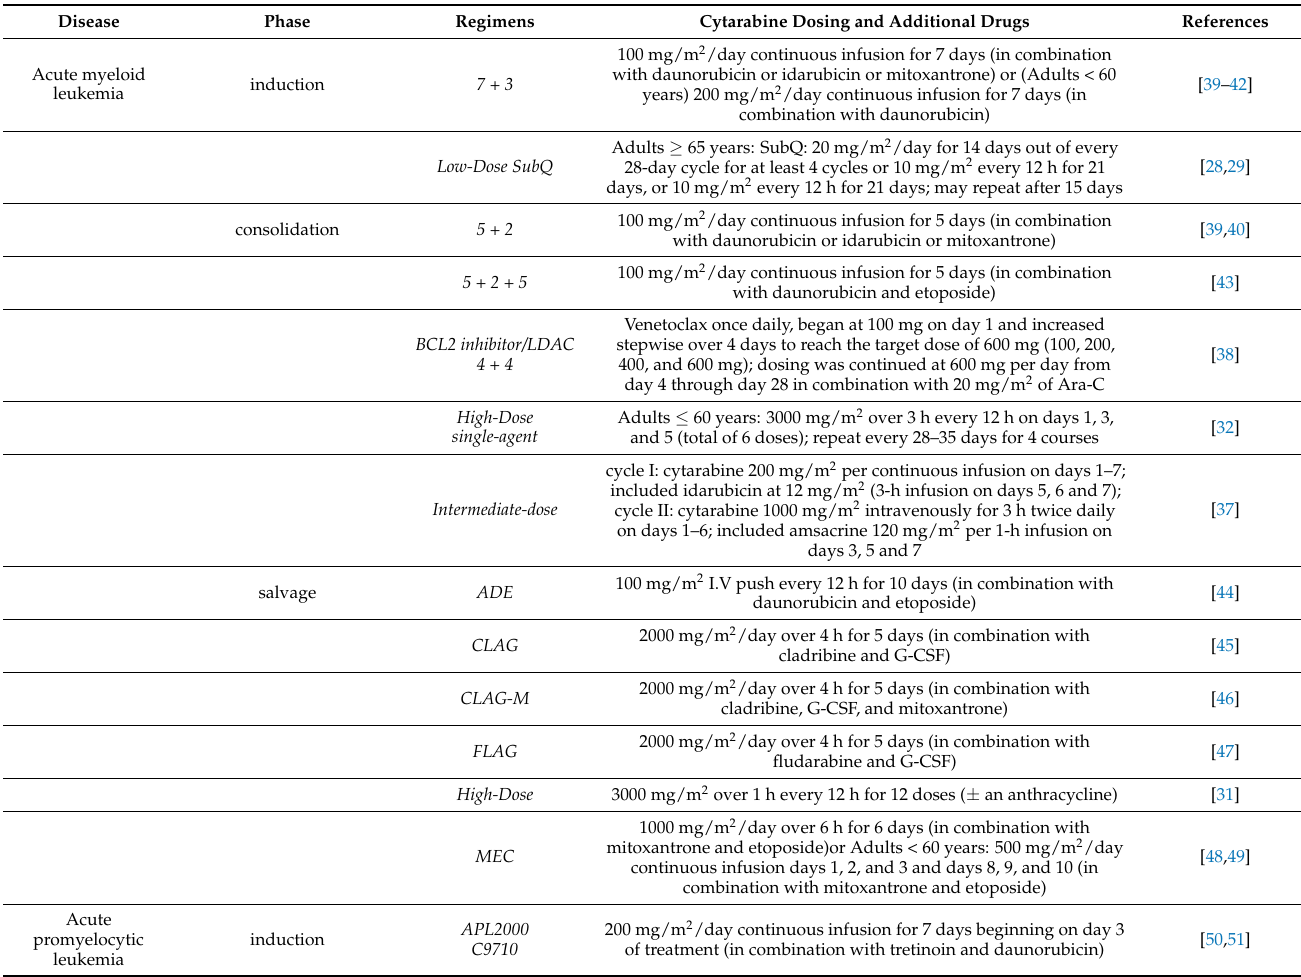
Table 1. Overview of cytarabine dose intensities and schedules in regimens for acute myeloid leukemias in adults. Details concerning dosing in combination regimens should also be